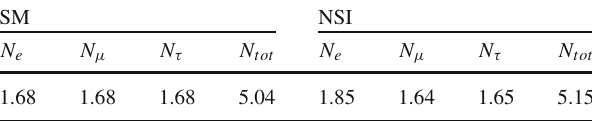
Fig. 3 Variation of total cross section (i.e. the sum of CC and NC interactions, NC includes both the cases of SM and NSI) along with the cross section of black hole formation Table 2 Number of shower events created in the process ν N → lX ( l = e ,μ,τ ) for both SM and NSI. N e , N μ and N τ are the number of events created individually by ν e , ν μ and ν τ ,